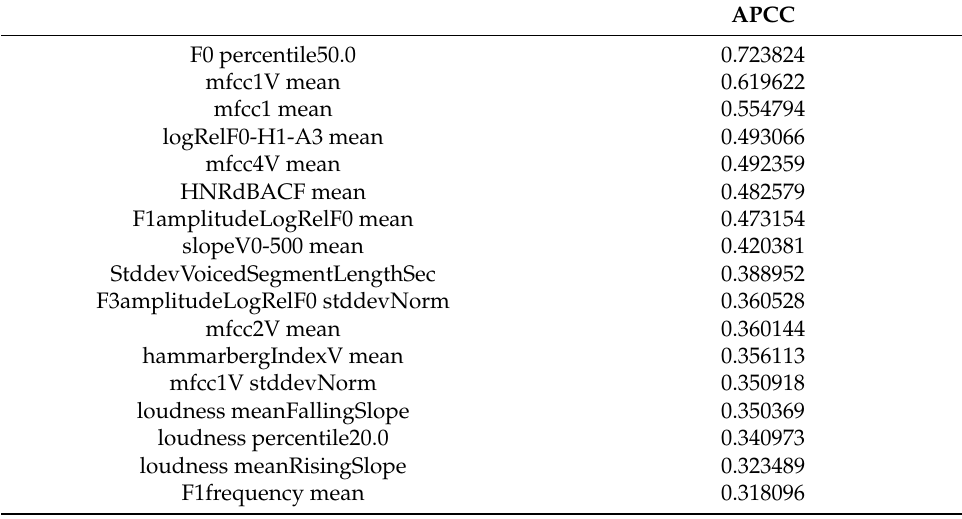
Table 1. APCC values between the best possible hyperplane of the latent space and audio features of the eGeMAPS feature